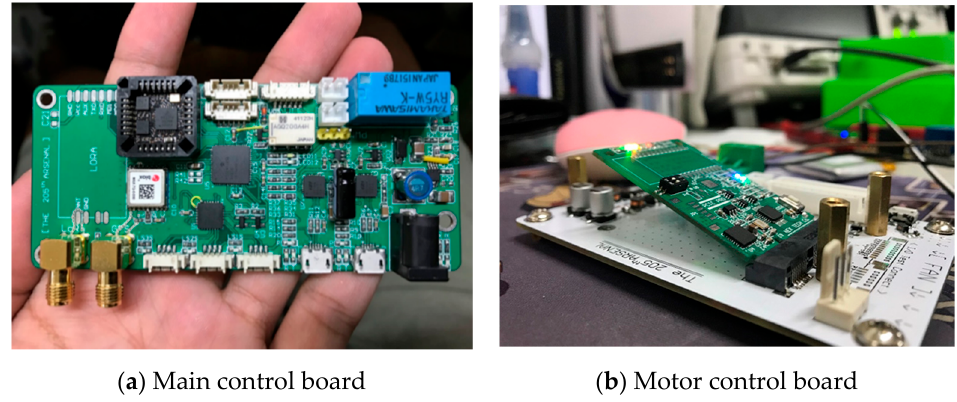
Figure 12. 3D simulation and physical circuit picture of the main control unit and motor control unit.